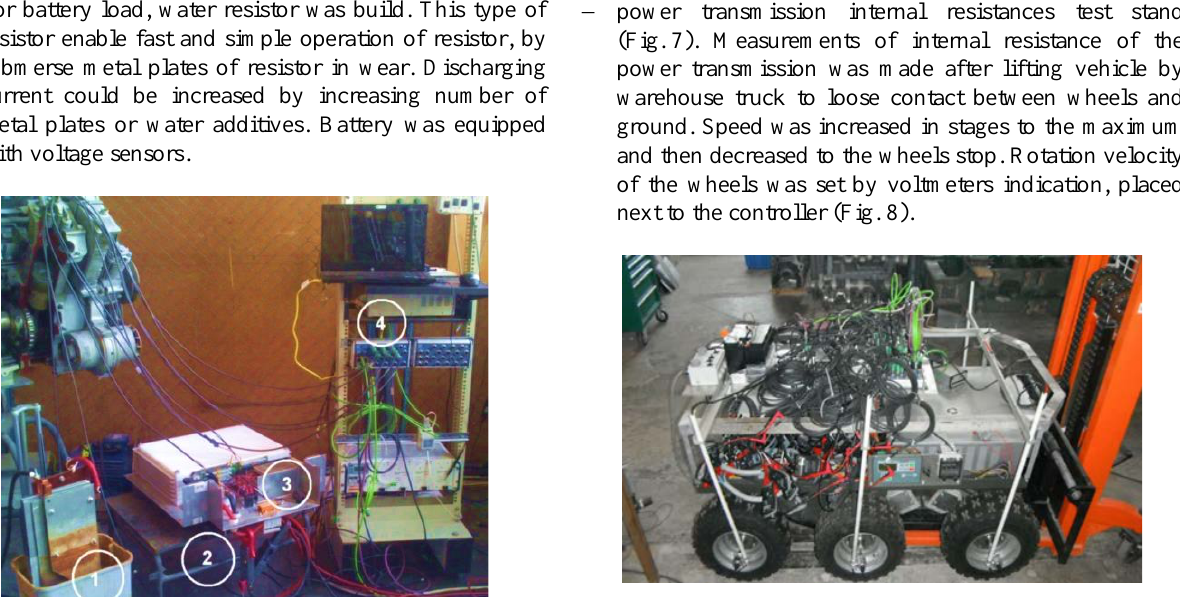
Fig. 7. Internal resistance measurements